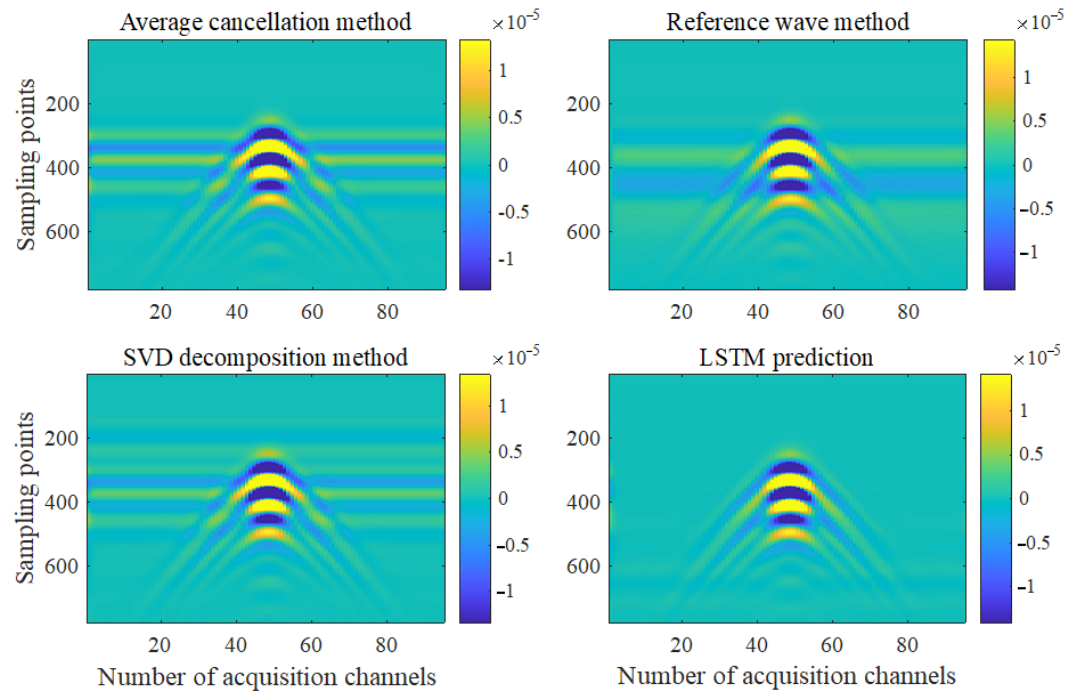
Figure 8. Wavelet removal extracted by four methods.